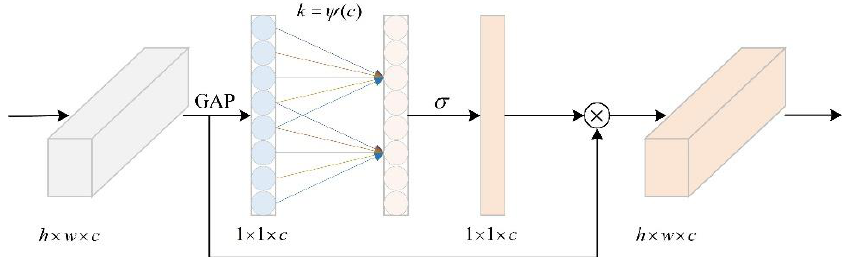
Figure 4. Structure of the ECA module.